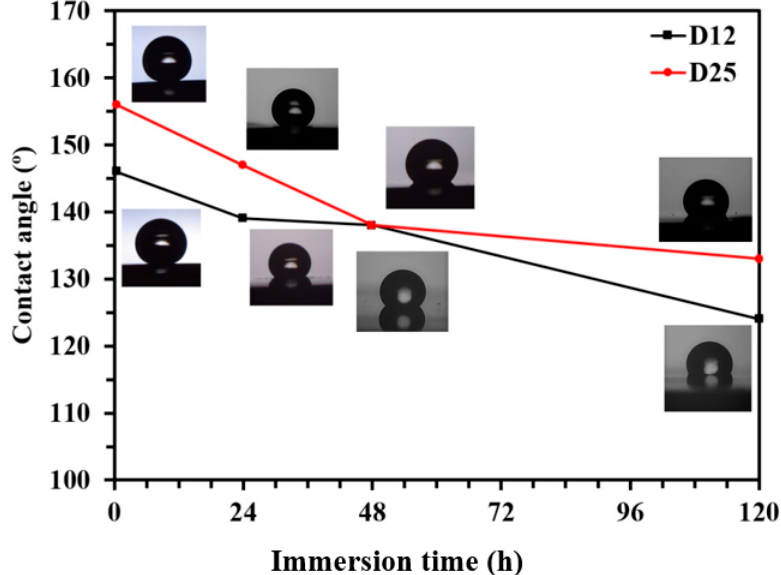
Figure 4. Changes of water contact angle (CA) of functionalized D12 and D25 surfaces with immersion time in 3.5 wt % NaCl solution. Lines connecting symbols (experiment data) are guides; CA values are the average of at least three measurements with <2% standard deviation.